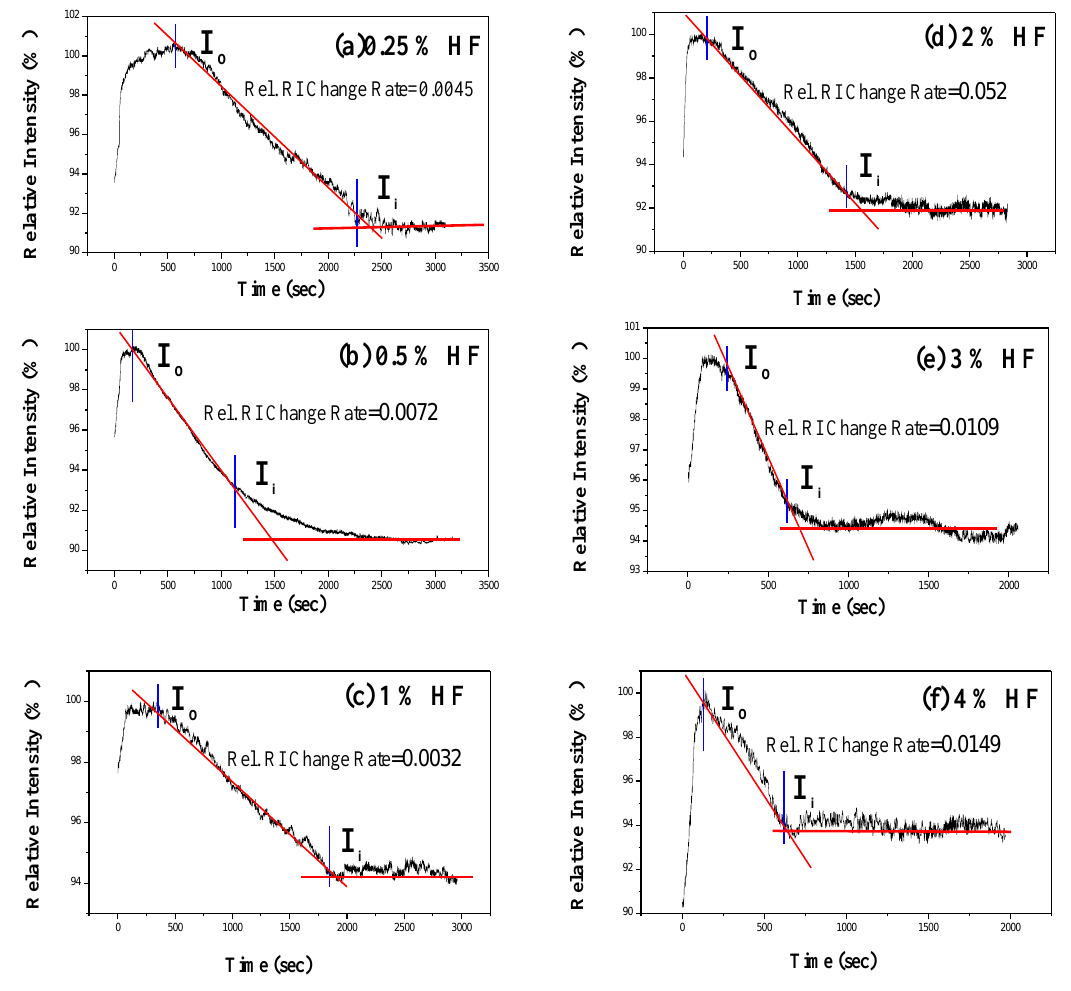
Figure 11. The comparison of relative RI change rates from calculation of the dynamic responses of SiO /LSPR sensing probe to HF solutions in different concentrations (0.25%, 2 0.5%, 1.0%, 2.0%, 3.0% and 4.0%). The formation of SiO with R = 10, pH = 4, after standing for 3